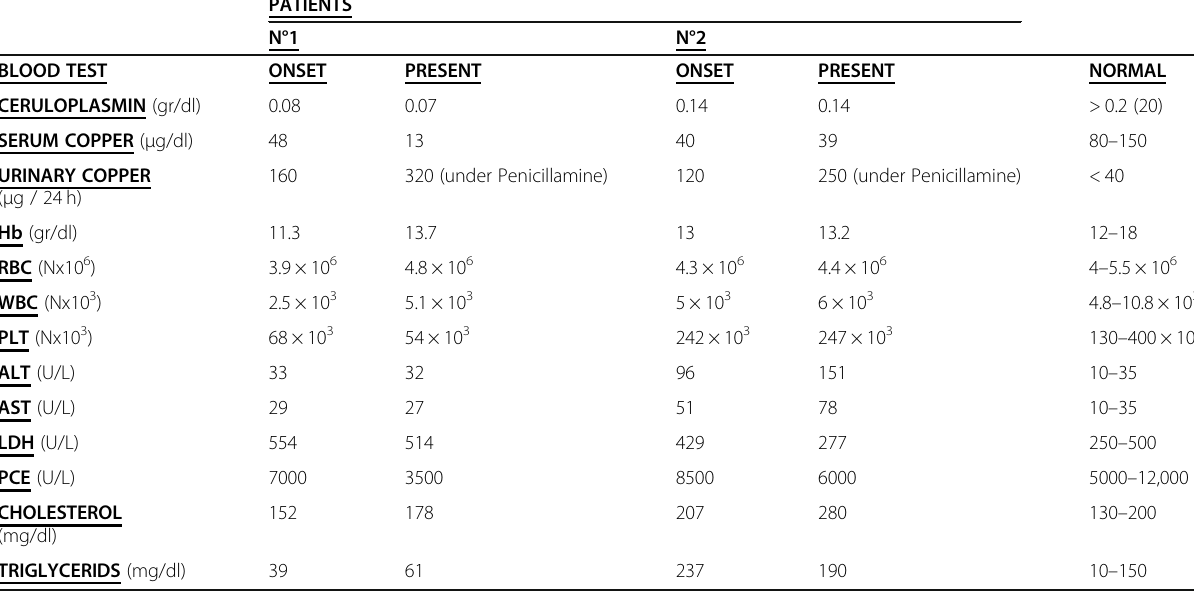
Table 1 Laboratory blood sample test comparison between the two patients of our study PATIENTS N°1 N°2 BLOOD